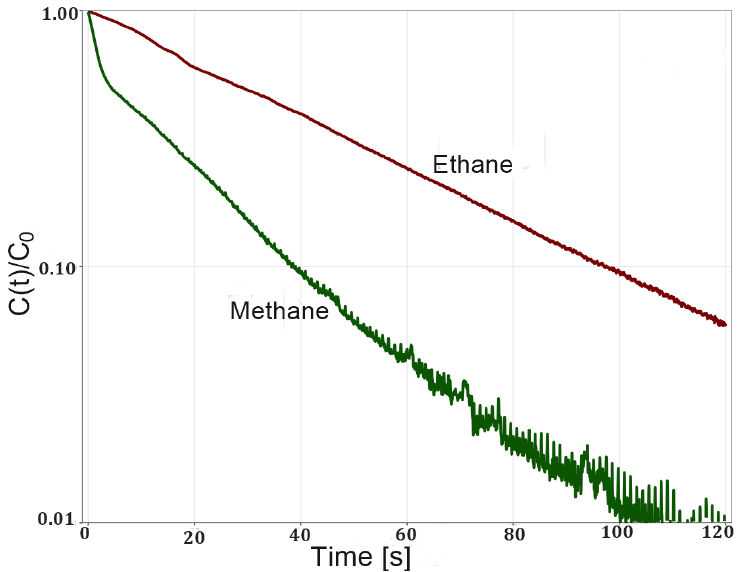
Figure 5. Experimental ZLC desorption curves of methane and ethane on zeolite 5A at 298K and flow rate of